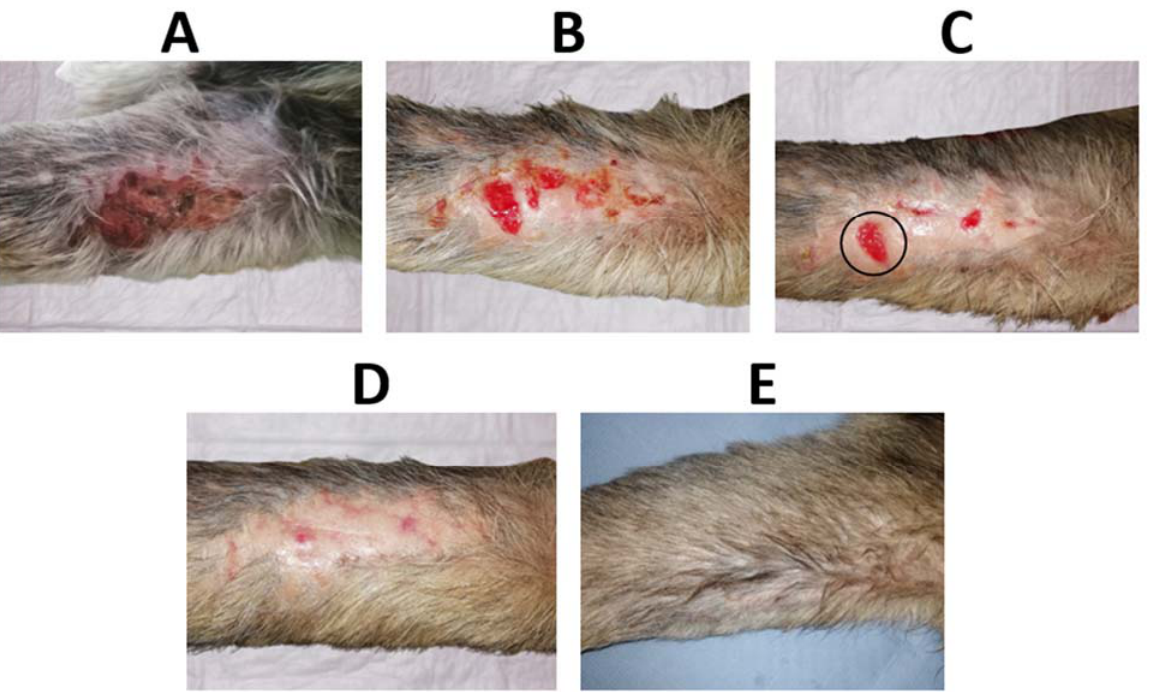
Figure 10. ( A ) Initial cranial wound on the left thoracic limb (untreated, 1st day), ( B ) wound on day 4, ( C ) wound on day 7, ( D ) wound on day 13, and ( E ) wound after 56 days of treatment with the antiseptic-loaded casein hydrogel. The wound limited by the black circle in ( C ) will be compared with a similar wound in Figure 12.